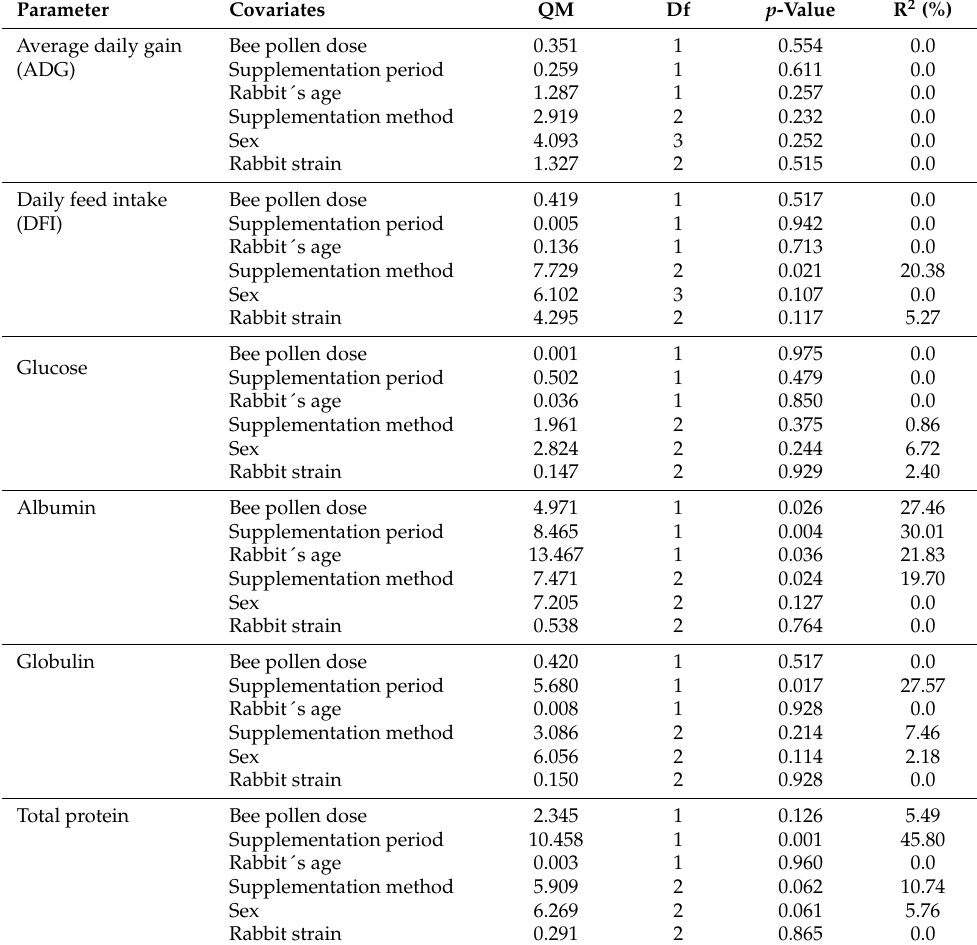
Table 6. Meta-regression comparing the associations between covariates and measured outcomes. Parameter Covariates